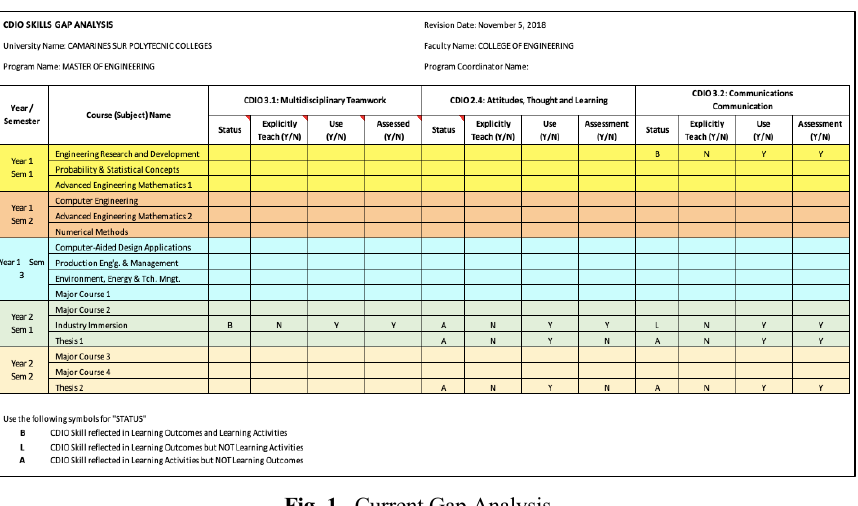
Fig. 1. Current Gap